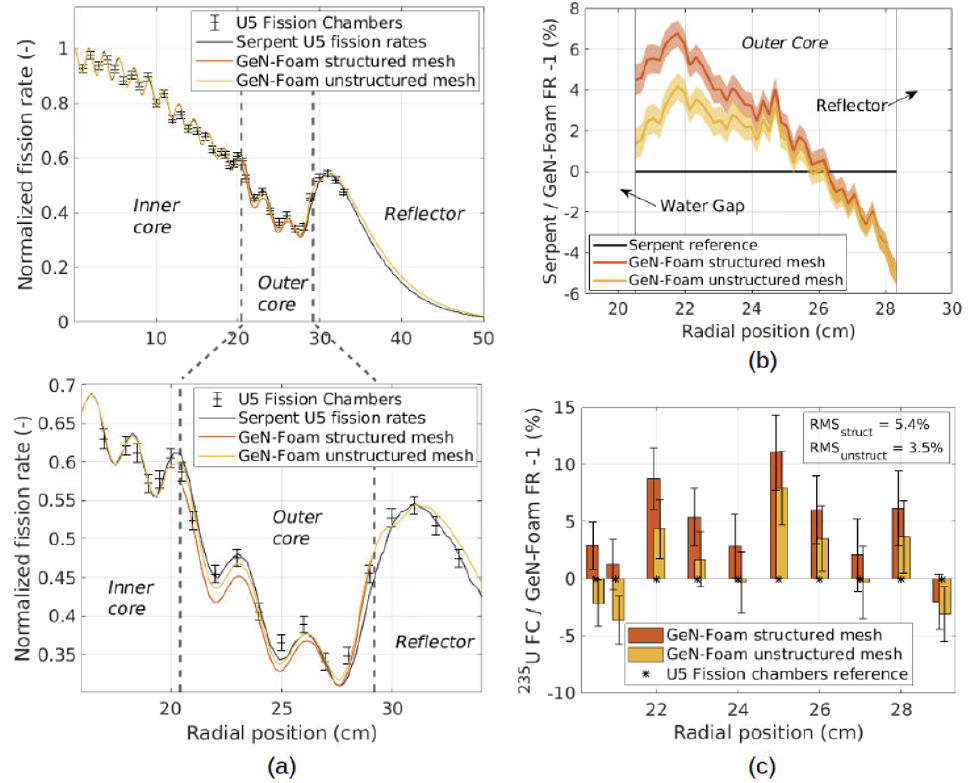
Figure 6. ( a ) Fission rate radial profiles, normalized to their core center values. Pin-by-pin power reconstruction was performed on the GeN-Foam profiles. ( b ) Code to code and ( c ) code to experiments validation of the GeN-Foam model, with a focus on the outer core